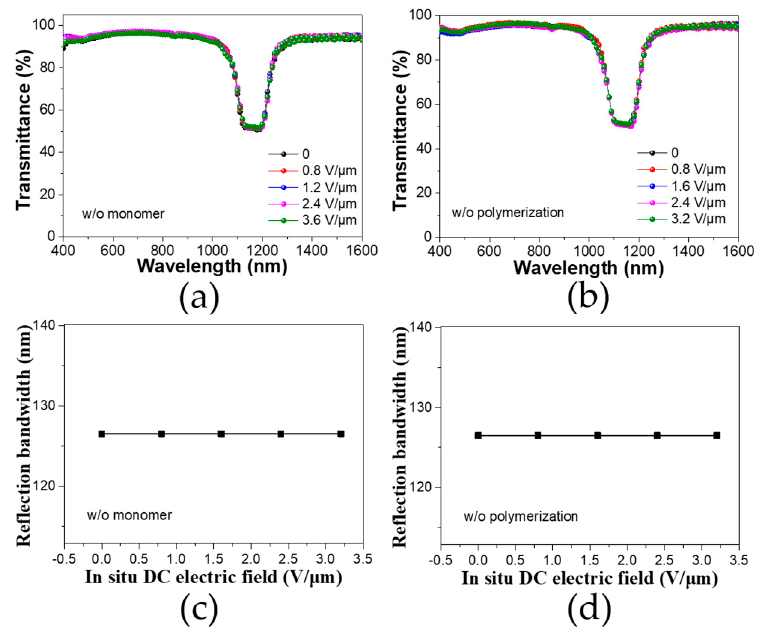
Figure 4. Transmittance spectra of a CLC cell without either monomers ( a ) or photo-polymerization ( b ) under different DC bias treatments; reflection bandwidth of the CLC cell without either monomers ( c ) or photo-polymerization ( d ) under different DC biases. Legend: w / o , without.